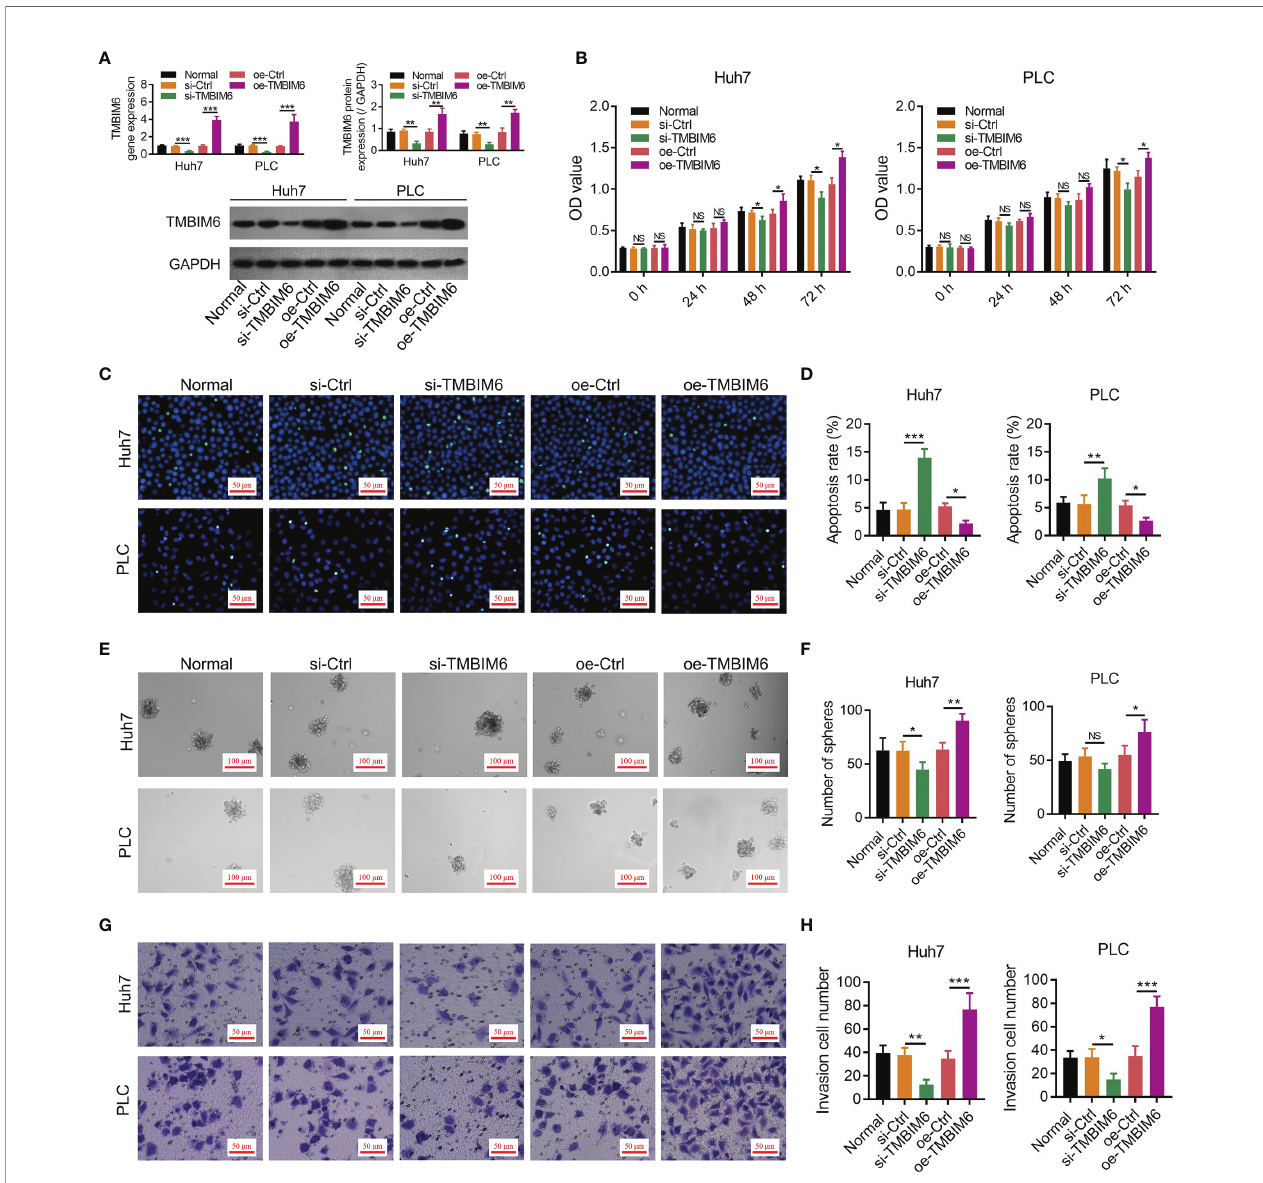
FIGURE 4 | Effect of TMBIM6 on viability, apoptosis, sphere formation ability, and invasion of HCC cells. Expression of TMBIM6 in Huh7 and PLC cells after transfection (A) . Comparison of viability (B) , apoptosis (C, D) , sphere formation ability (E, F) , and invasion (G, H) among groups in Huh7 and PLC cells. HCC cells were cultured normally or transfected with control siRNA, TMBIM6 siRNA, control overexpression plasmids, or TMBIM6 overexpression plasmids. Green cells indicate apoptotic cells in panel (C) Purple cells indicate invaded cells in panel (G) . NS, not signi fi cant; * p < 0.05; ** p < 0.01; *** p < 0.001. HCC, hepatocellular